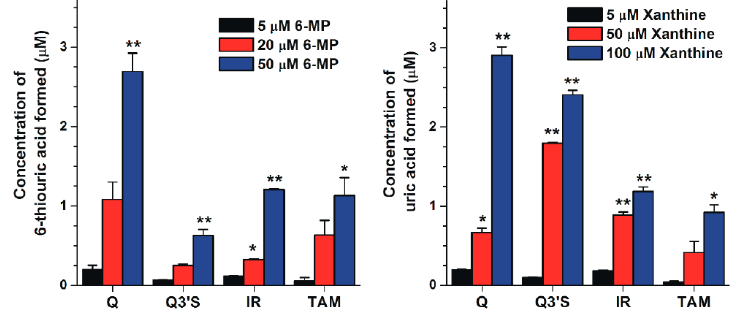
Figure 5. Concentrations of 6-thiouric acid ( left ) and uric acid ( right ) formed in the presence of 3 and 10 μ M flavonoid concentrations, respectively (substrate concentrations are indicated in the figure; * p < 0.05, ** p < 0.01).